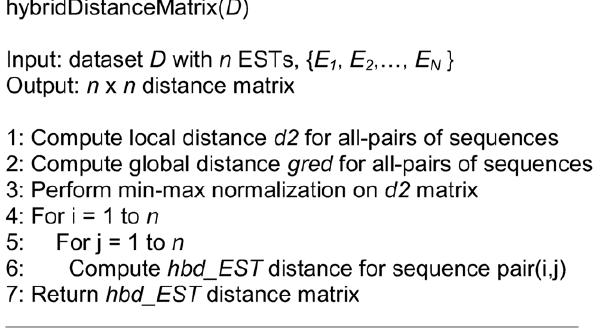
Figure 2. The algorithm for computing the hbd_EST distance